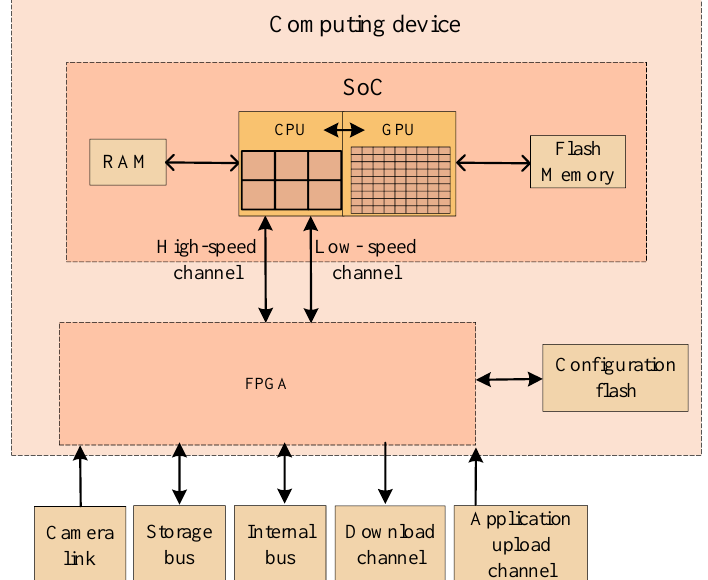
Figure 3. Concept of on-board hardware architecture.